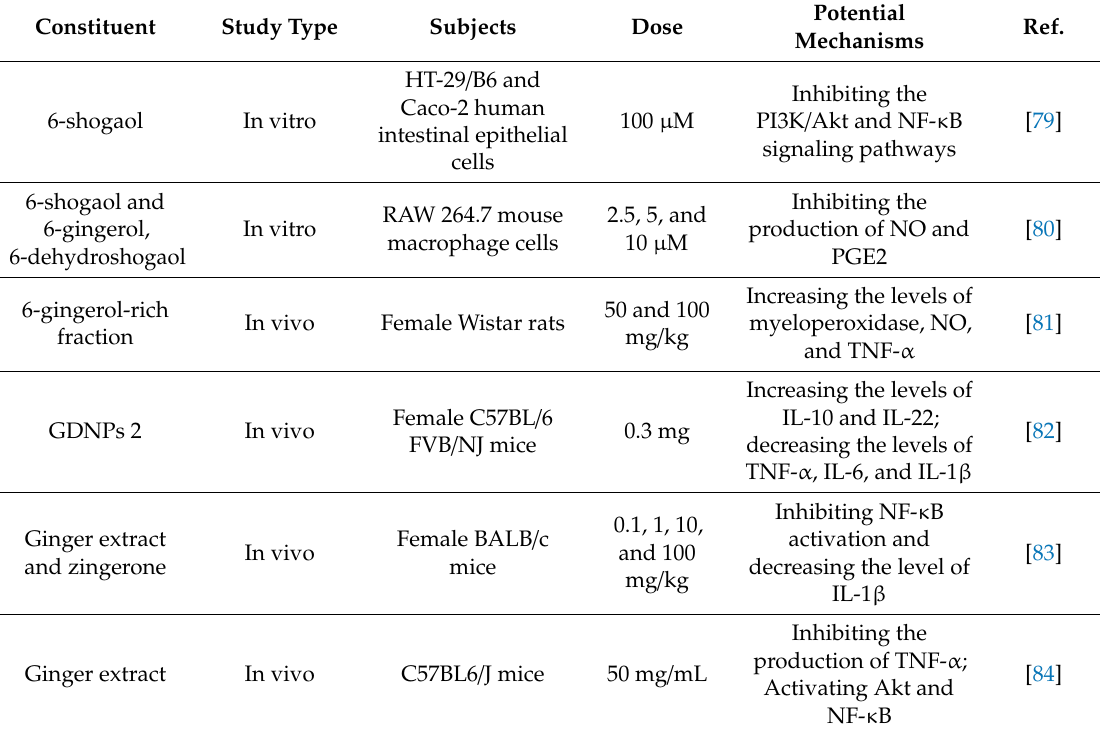
Table 5. Anti-inflammatory activity and potential mechanisms of